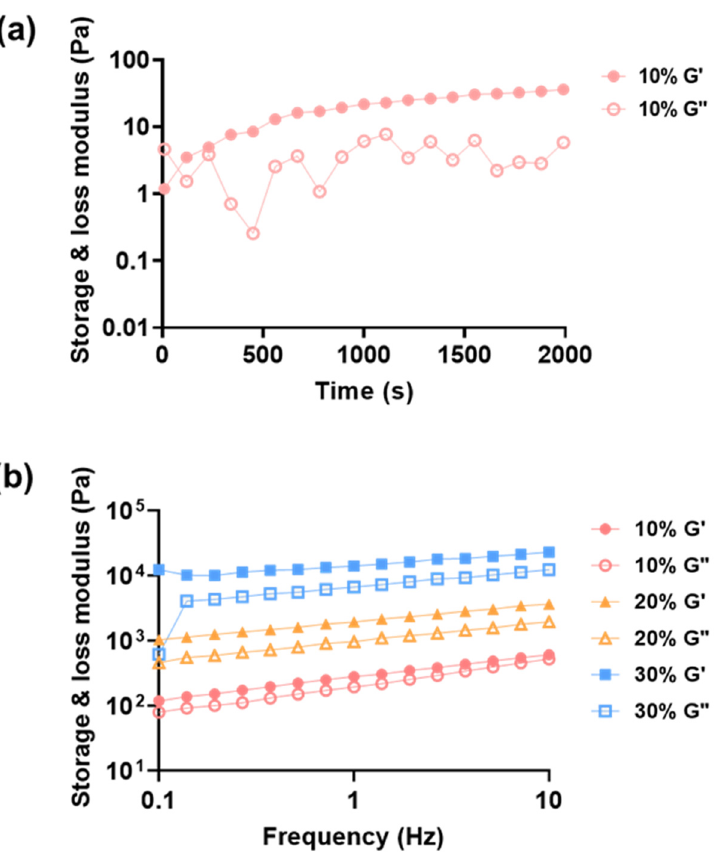
Figure 4. Variation of dynamic moduli (G’: storage moduli, G”: loss moduli) of furfuryl-gelatin hydrogels with ( a ) time for 10% furfuryl-gelatin and ( b ) frequency for 10%, 20%, and 30% furfuryl- gelatin.